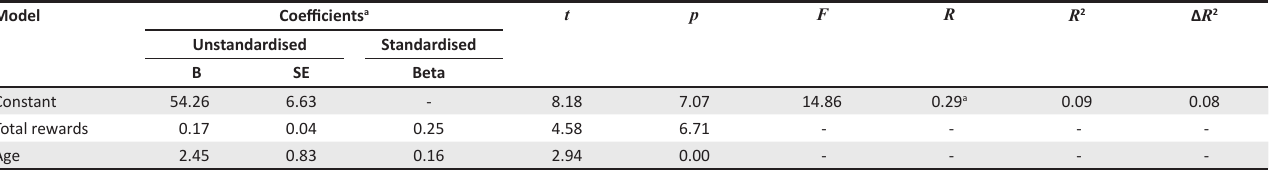
TABLE 7: Moderated regression analysis with age as moderator between work engagement and total rewards. Model